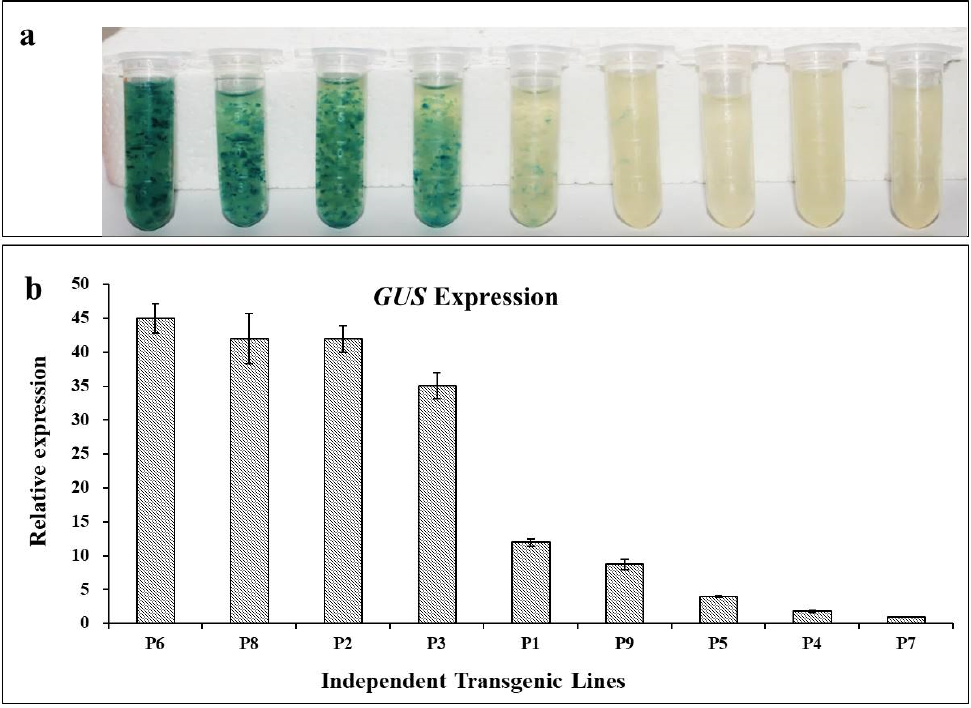
Figure 4. Histological GUS assay and GUS expression in different transformed lines. ( a ) Histo- chemical staining for GUS staining in transgenic lines P1 to P9. ( b ) Expression of GUS in transgenic lines P1 to P9 as assessed by qRT-PCR.